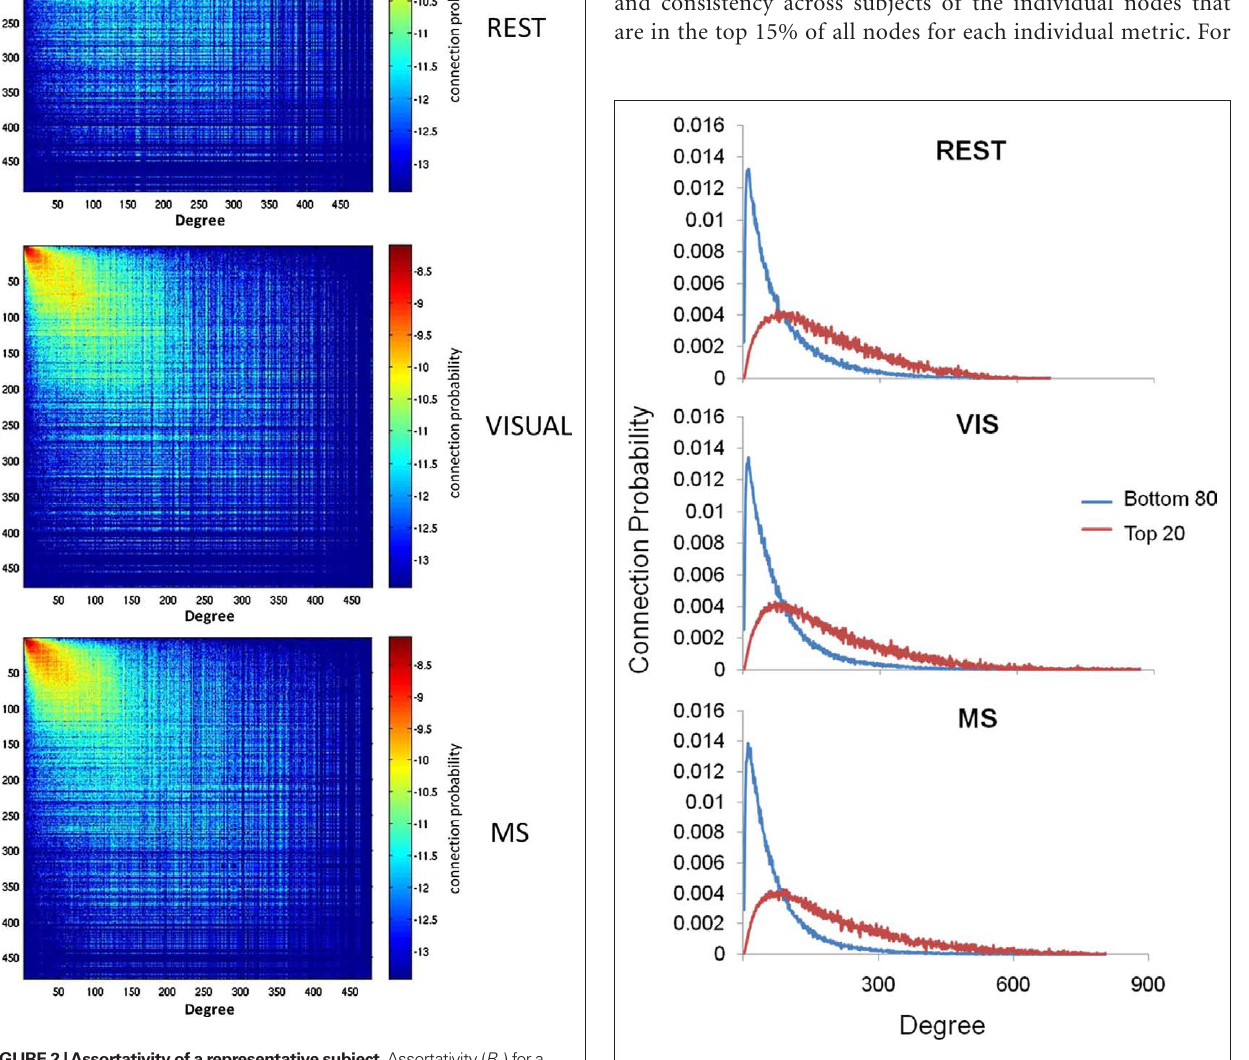
Figure 2 | Assortativity of a representative subject. Assortativity ( R single subject across all three conditions (rest, visual, and multisensory). The matrix depicts the degree of all connected nodes, generated by plotting the degree of each node on either end of each network edge. The warm region in the upper left corner of the plots denotes that the majority of network nodes have a low degree and are connected with other low degree nodes. The assortativity plots for the rest (REST), visual (VIS), and multisensory (MS) tasks all show a positive assortativity, in which nodes with similar degree are connected.